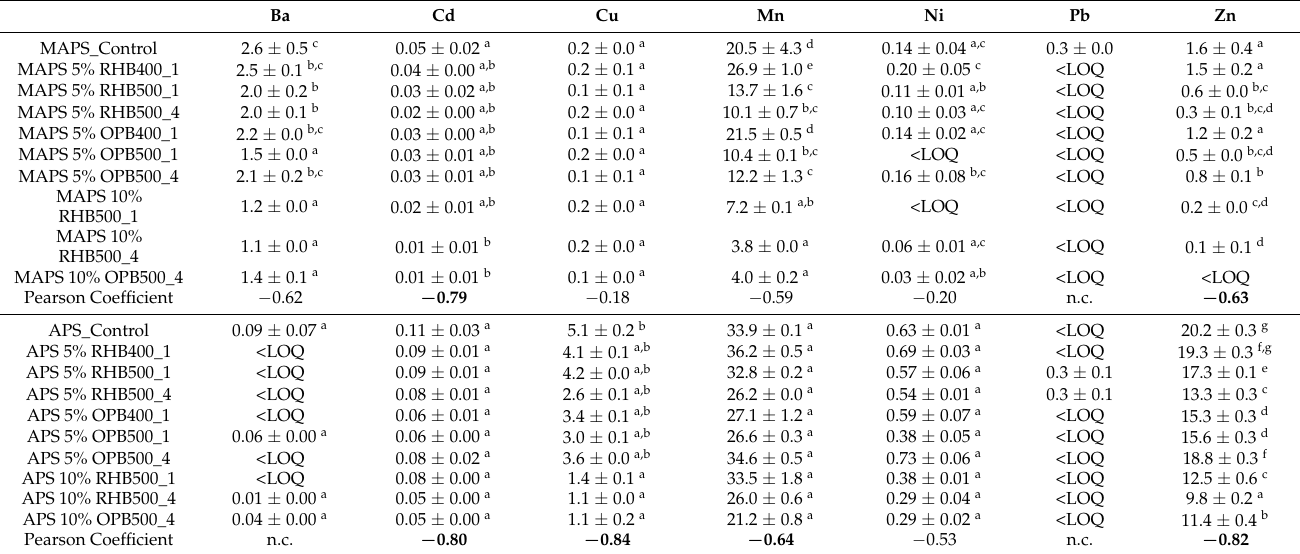
Data are presented as mean values ± standard error. Pearson coefficient between pH values and extractable trace elements. Coefficients in bold are significant ( p < 0.05). <LOQ = below limit of quantification; n.c. = correlation was not calculated. For each soil, values in the same column followed by the same letter are not statistically different ( p <